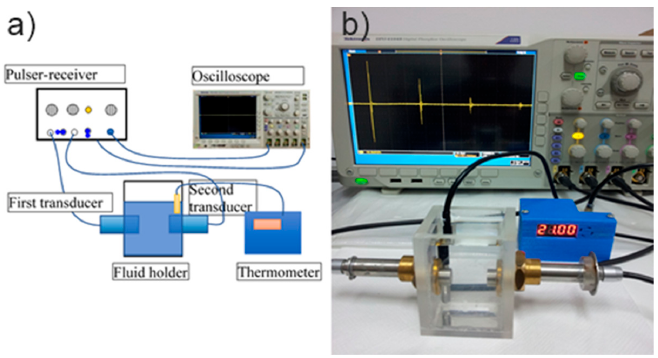
Figure 1. Experimental setup: Schematics ( a ) and image ( b ).